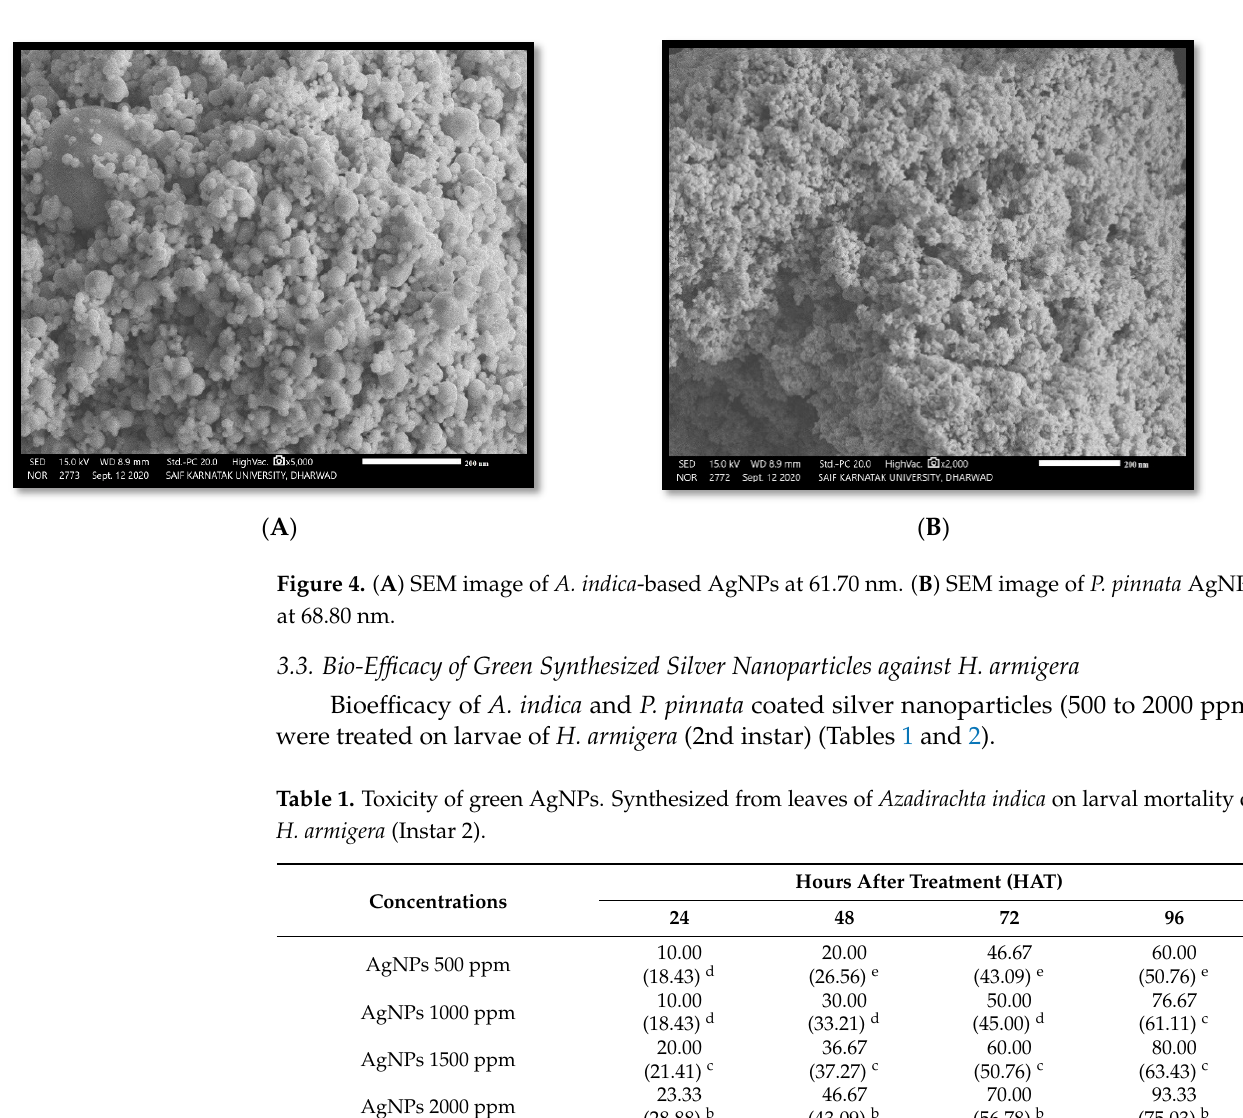
Figure 3. ( A ) PSAimage of A. indica -based AgNPs at 61.70 nm. ( B ) PSA image of P. pinnata AgNPs at 68.80 nm.